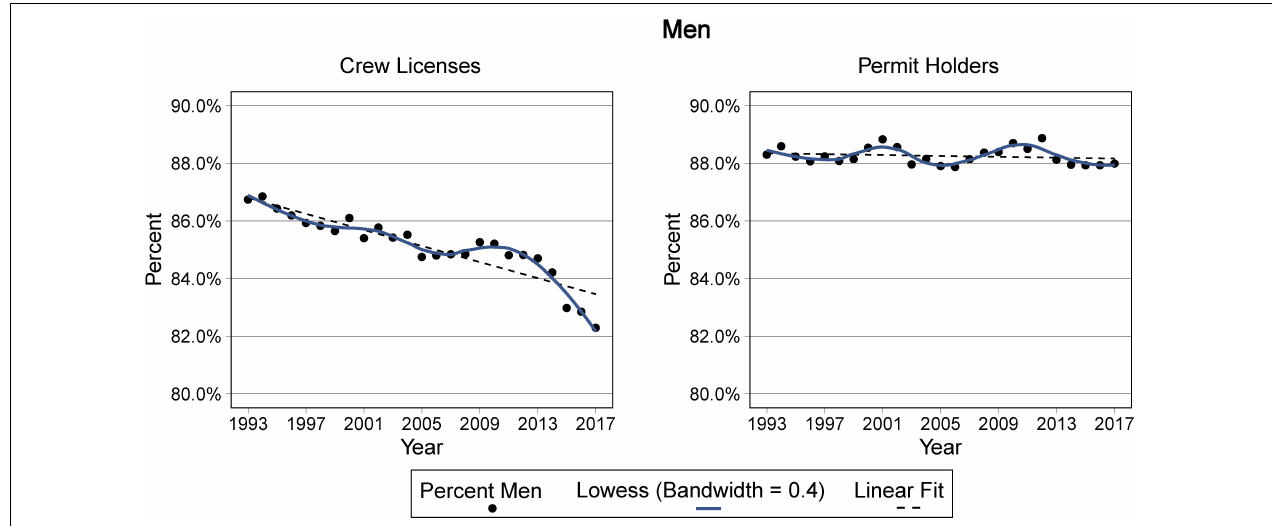
FIGURE 4 | The percent of men crew license holders and permit holders from 1993 to 2017. The points represent the percent of annual participants, the black dashed lines are the linear fit and the blue solid lines the locally weighted scatterplot smoothing (LOWESS) fit curve with a 0.4 bandwidth.